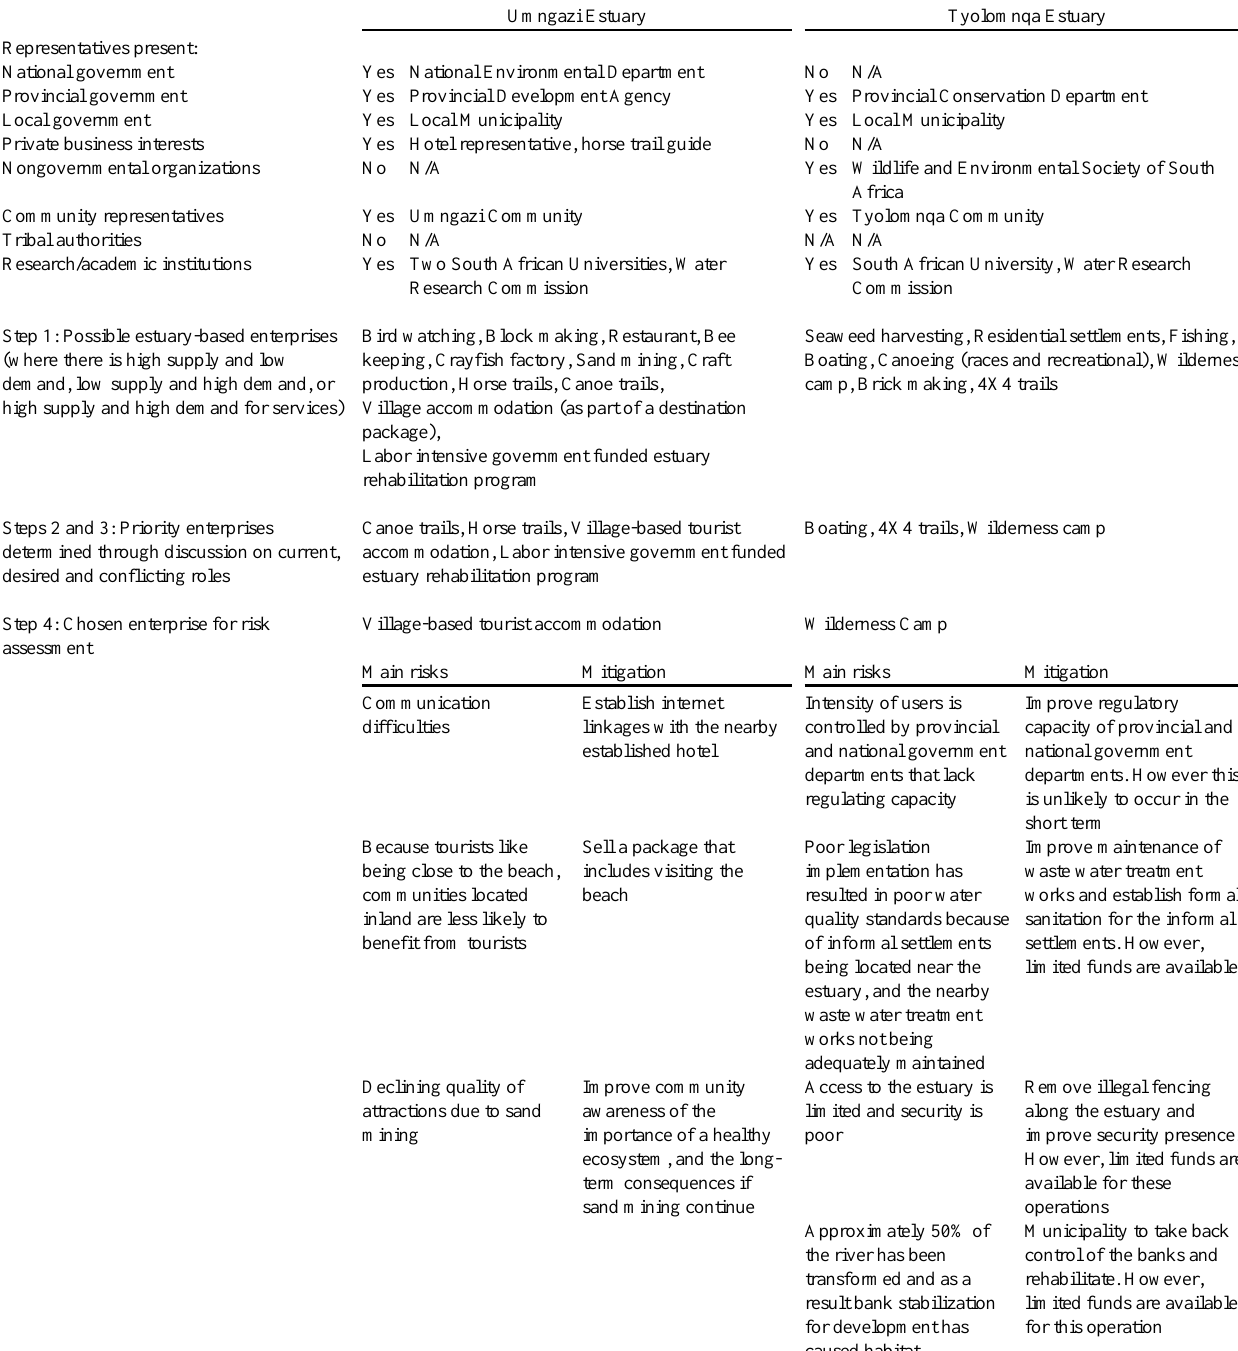
Table 5 . Concise results from testing the toolkit at Umngazi estuary and the Tyolomnqa estuary